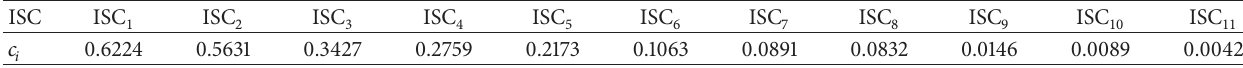
Figure 2: Time domain waveforms for seven running conditions of roller bearing. (a) Normal condition, (b) inner-race fault with fault diameter of 0.007 inches, (c) outer-race fault with fault diameter of 0.007 inches, (d) ball fault with fault diameter of 0.007 inches, (e) inner- race fault with fault diameter of 0.021 inches, (f) outer-race fault with fault diameter of 0.021 inches, and (g) ball fault with fault diameter of 0.021 inches. Table 2: Cross-correlation coefficient between the 𝑖 th ISC and the original